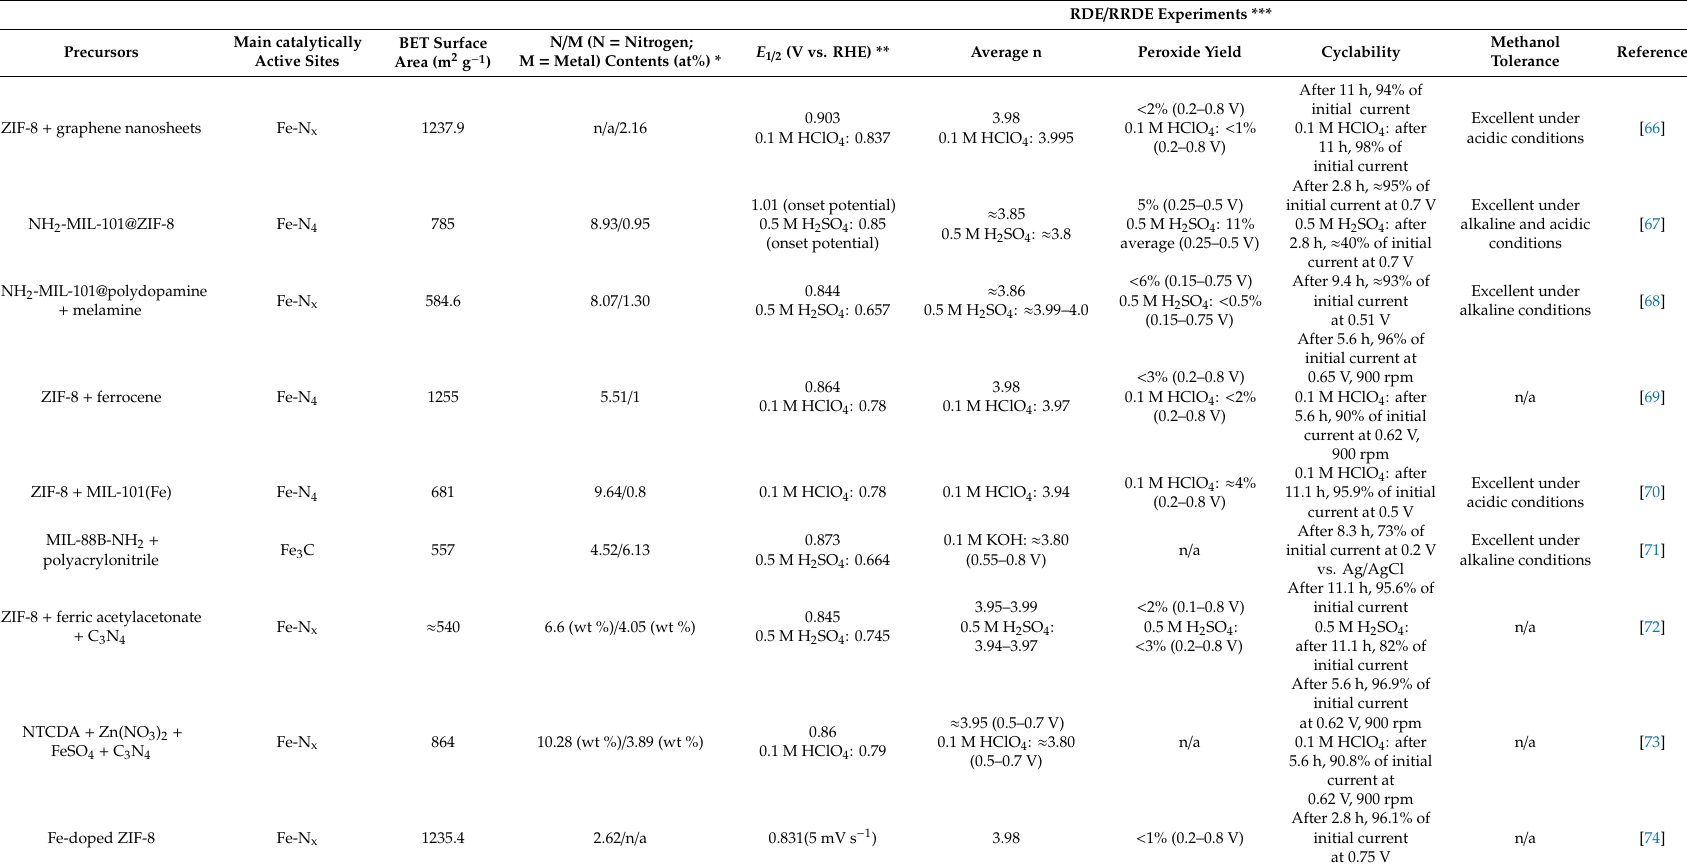
Table 3. Recent research works (2018–2020) dealing with the preparation of Fe-based electrocatalysts for fuel cells with a focus on ORR activity. Examples in acidic and alkaline media are provided, and major physicochemical properties and electrochemical performances realized using rotating electrodes are